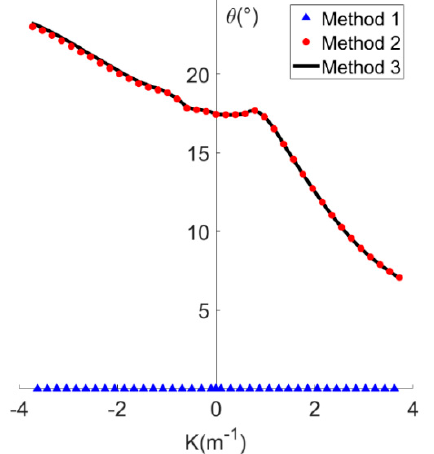
Figure 14. Rotation of neutral axis in CASE 1.